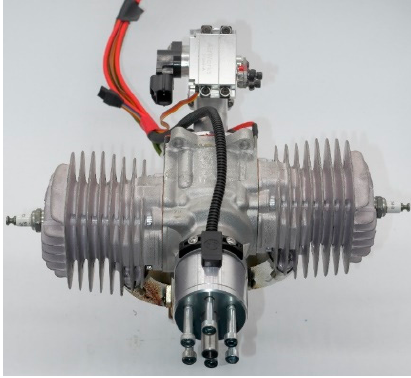
Figure 3. The two-stroke, SI aviation piston engine.